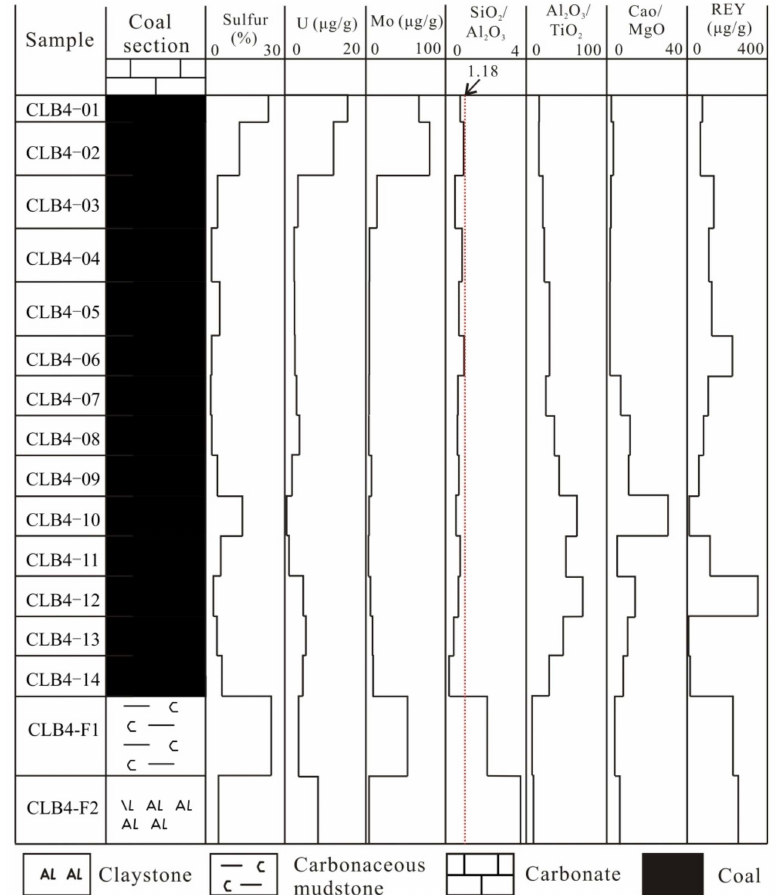
Figure 5. Vertical distribution of sulfur, U, Mo, REY, SiO 2 / Al 2 O 3 , Al 2 O 3 / TiO 2 , and CaO / MgO